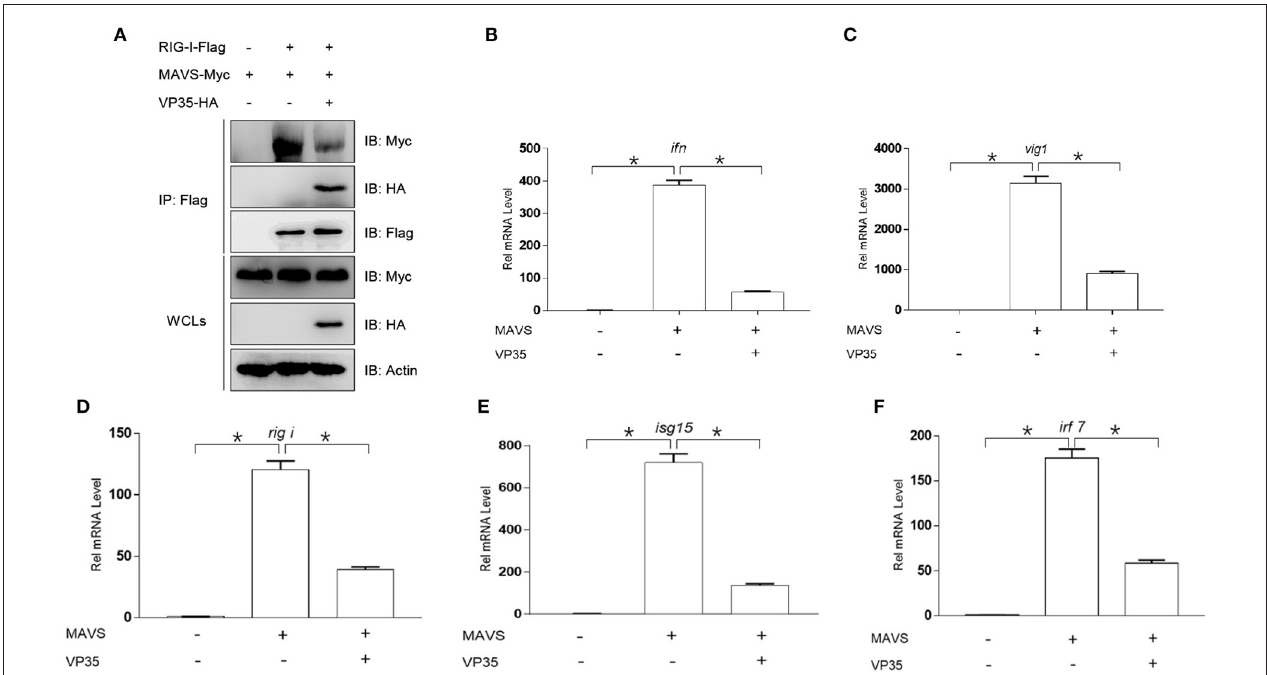
FIGURE 5 | VP35 affects MAVS-mediated signal transmission and the host IFN production. (A) HEK 293T was seeded in 10-cm 2 dishes and transfected with 4 µ g RIG-I-Flag, 4 µ g MAVS-Myc, and 4 µ g VP35-HA. After 24h, the cells were lysed for co-immunoprecipitation (Co-IP) with Anti-Flag Affinity Gel. Then the immunoprecipitate and WCLs were analyzed by IB with anti-Flag, anti-HA, anti-Myc, and anti- β -actin Abs. (B–F) EPC cells were seeded in six-well plates and transfected with 2 µ g MAVS-Myc and VP35-HA, after 24h, total RNAs were extracted to examine the transcriptional levels of ifn/vig1/rig-i/isg15/irf7 . The relative transcriptional levels were normalized to the transcriptional level of the β -actin gene and were represented as fold induction relative to the transcriptional level in the control cells, which was set to 1. Data are expressed as mean ± SEM, n = 3. Asterisks indicate significant differences from control values (* p <